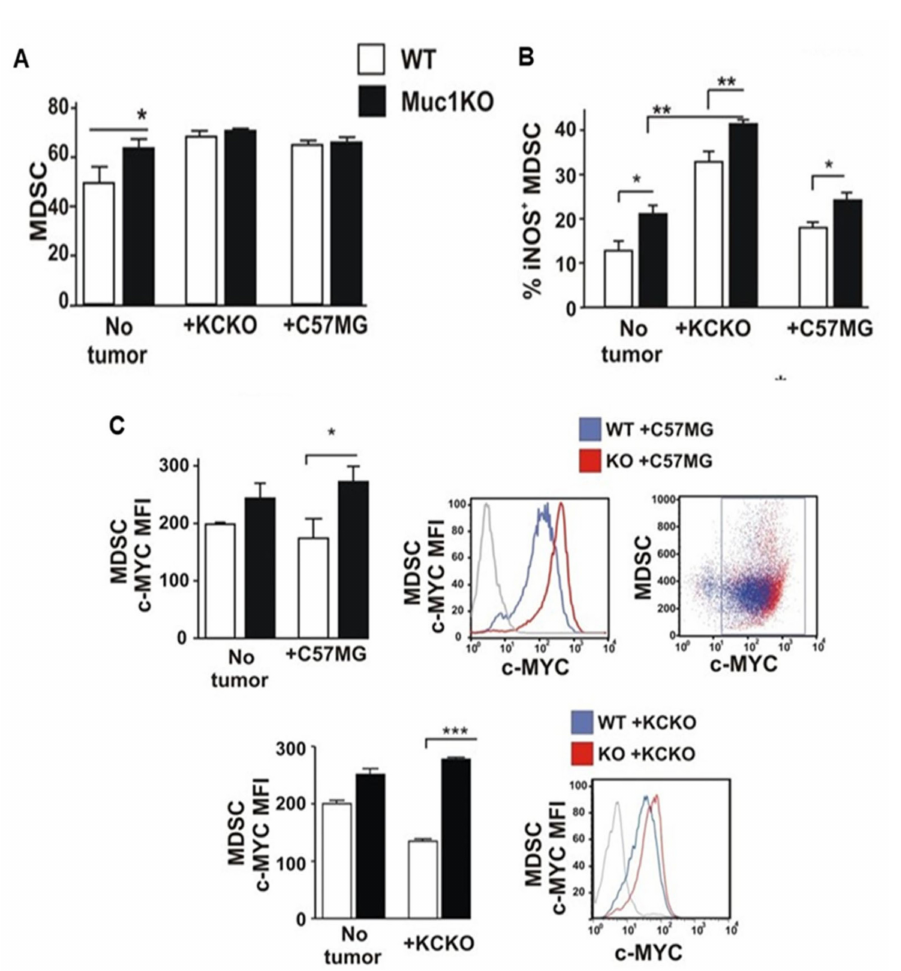
Figure 5. MDSCs from MUC1KO mice produce increased iNOS and c-Myc. ( A ) BM cells from healthy mice were isolated and labeled with antibodies against Gr1 and CD11b. ( B ) Level of iNOS expression by MDSCs from the BM of healthy and tumor bearing mice. Percentages of iNOS + cells on Gr1 + CD11b + BM gated cells. ( C ) MFI values of c-Myc protein expression by MDSCs from the BM of healthy and tumor bearing mice. c-Myc + cells were gated in Gr1 CD11b + cells. Welch’s t -test was used to compare between WT and MUC1KO groups and p < 0.01 was considered significant. * p < 0.05, ** p < 0.01, *** p <